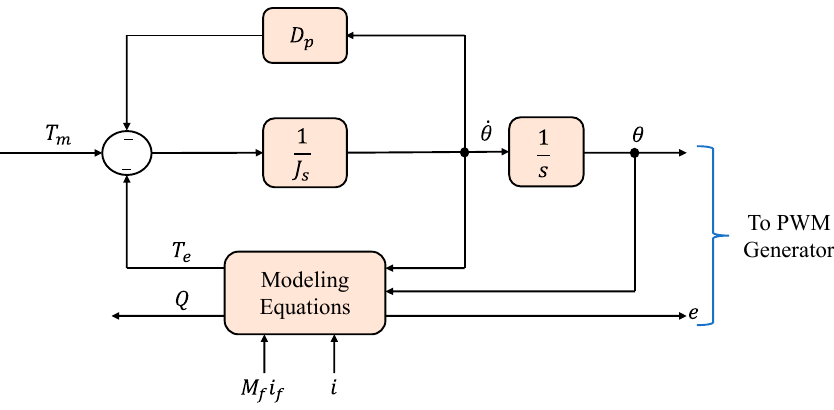
Figure 7. The components of a synchronverter: controller [26].